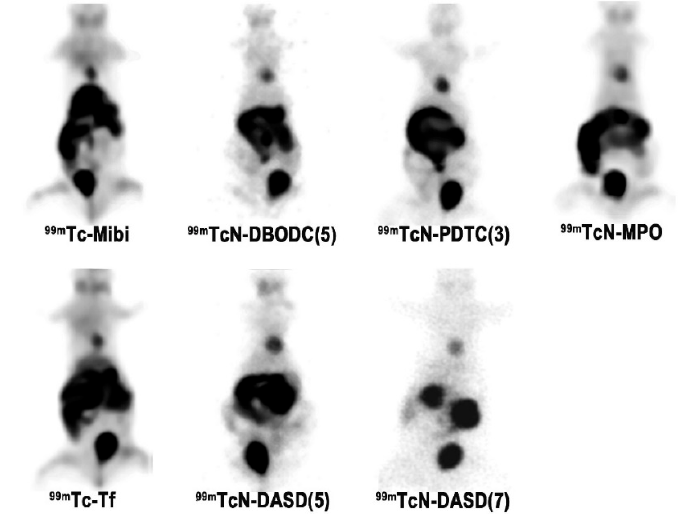
Figure 14. Planar imaging of selected [ 99m Tc][TcN(L)(PNP)] + compounds compared with those of commercially available MPIAs.